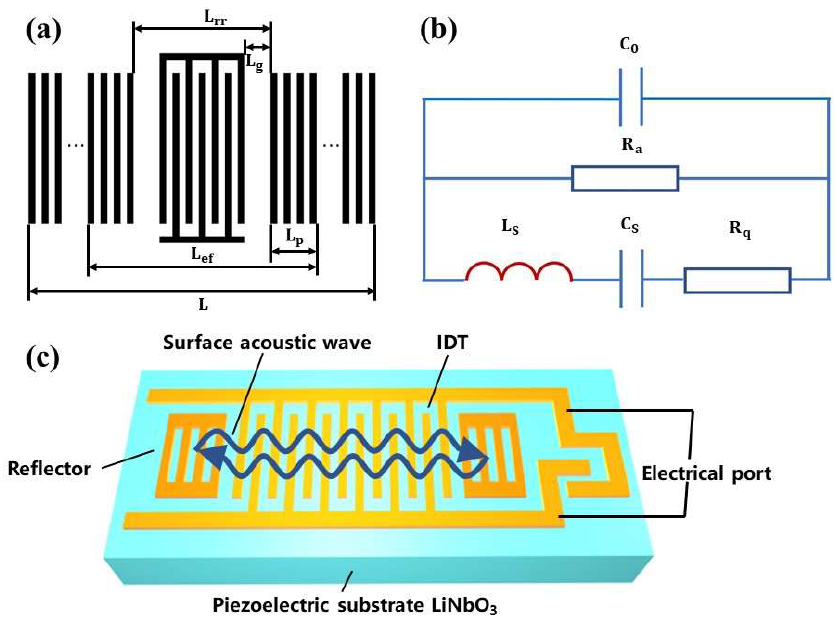
Figure 1. ( a ) Parameter diagram, ( b ) general equivalent circuit diagram, and ( c ) diagram of single port SAW resonator.